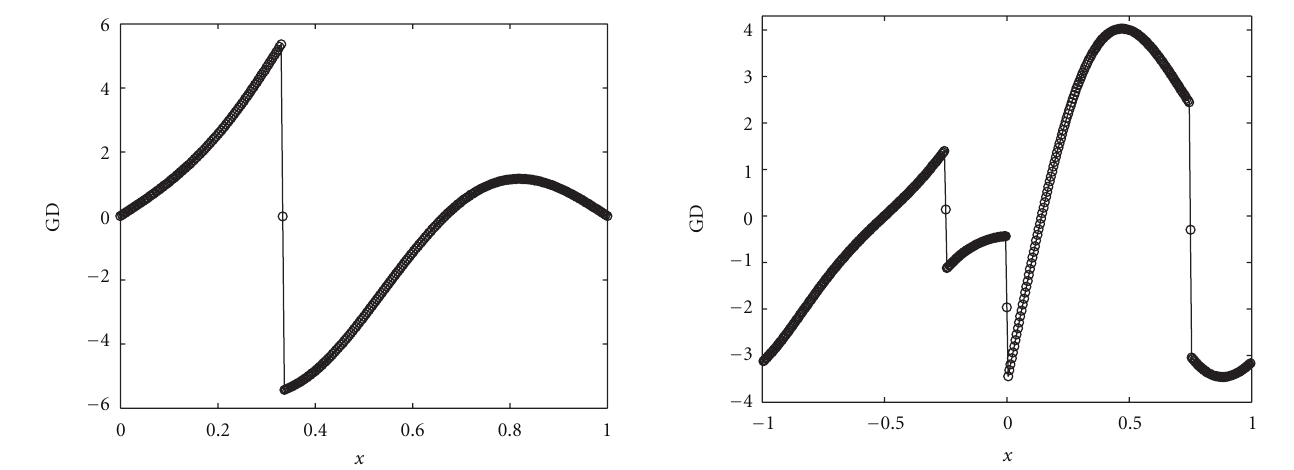
Figure 11: The graph of GD of Example